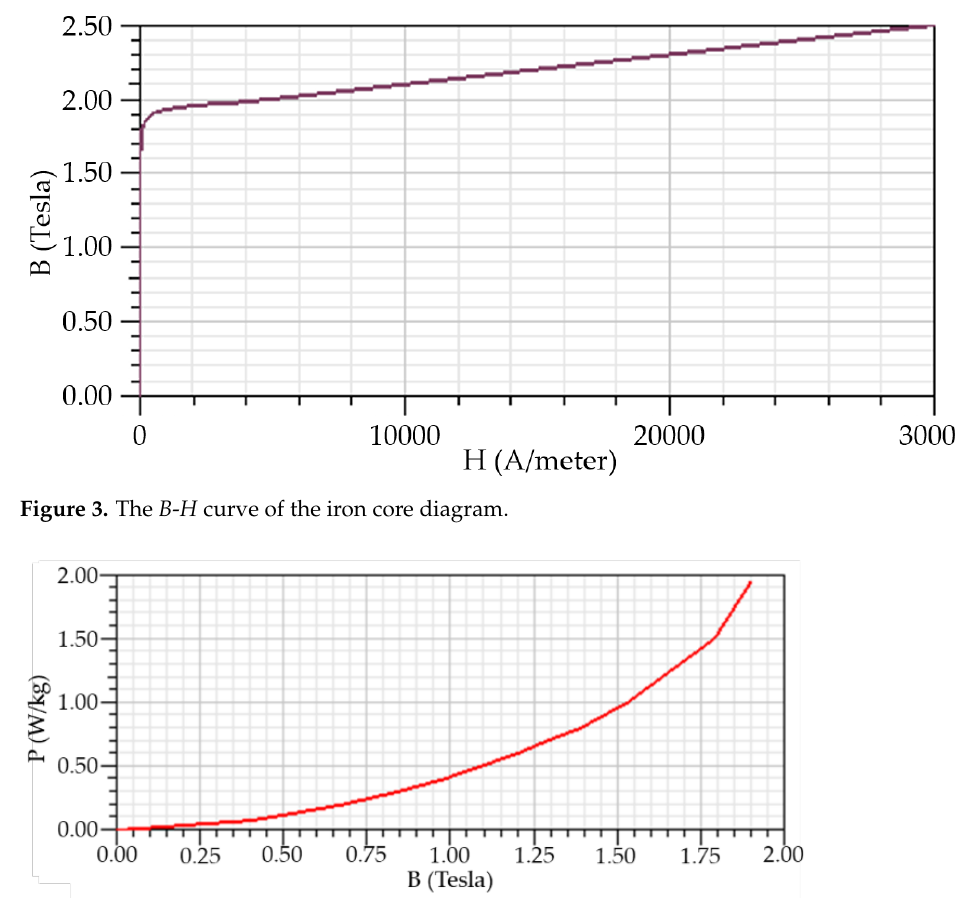
Figure 4. The P - B curve of the iron core diagram.